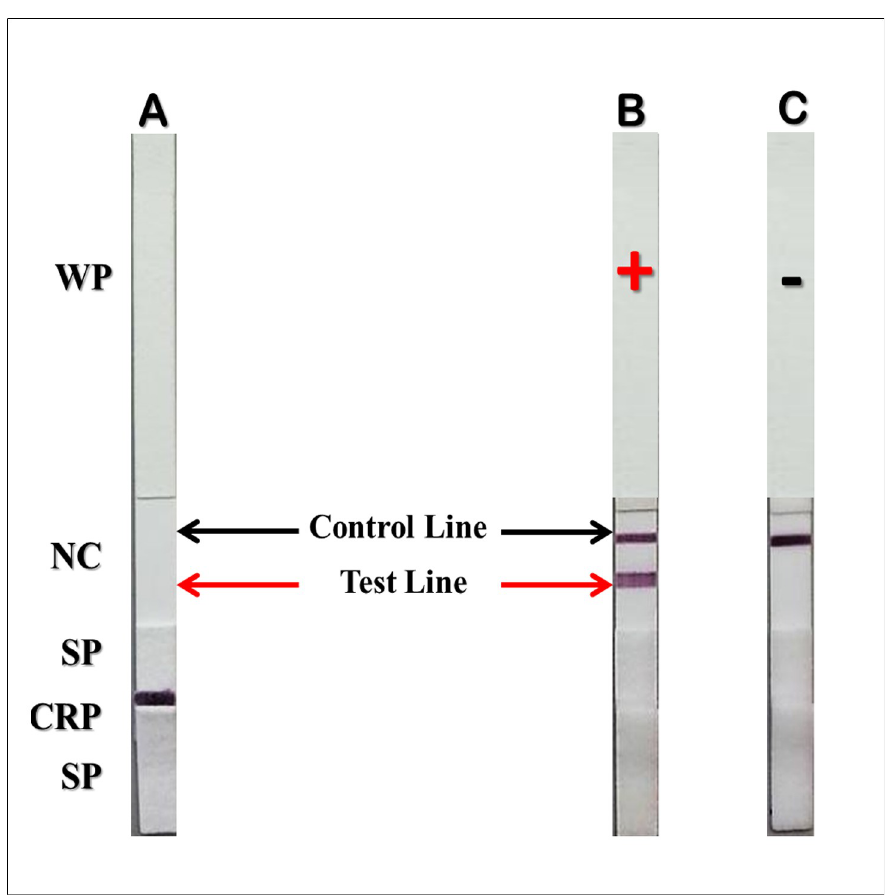
Fig 5. A picture of the GNA-MAb 4D1 sandwich ICT strip in the detection of TM CYA. (A) An untested strip with no signal at the test line or the control line, (B) Positive test result showing intense signals both at the test and at the control lines. (C) Negative result showing signal only at the control line. Abbreviations: WP, wicking pad; NC, analytical nitrocellulose membrane; SP, sample application pad; CRP, conjugate releasing pad.